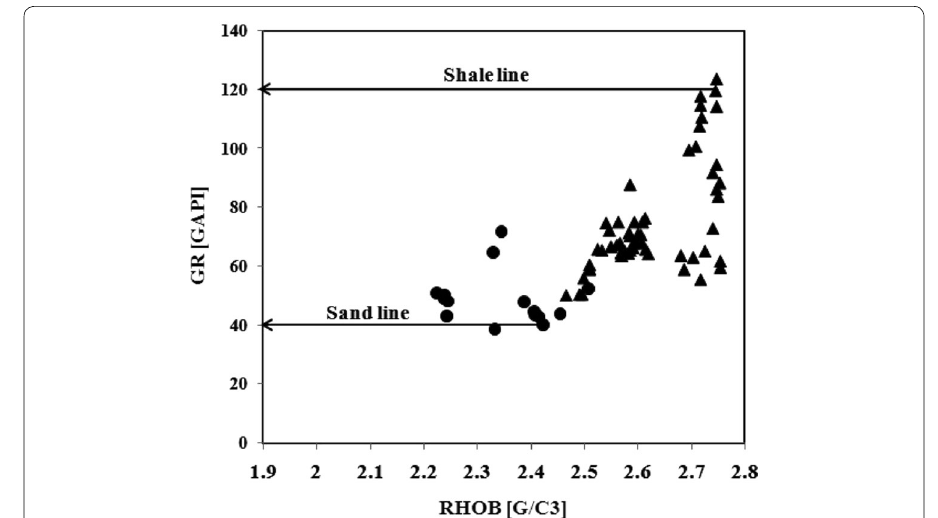
Fig. 6 Density vs GR in the core samples of the Shurijeh Formation. Black circle Gas producing well data points, and black up-pointing triangle non producing well data points